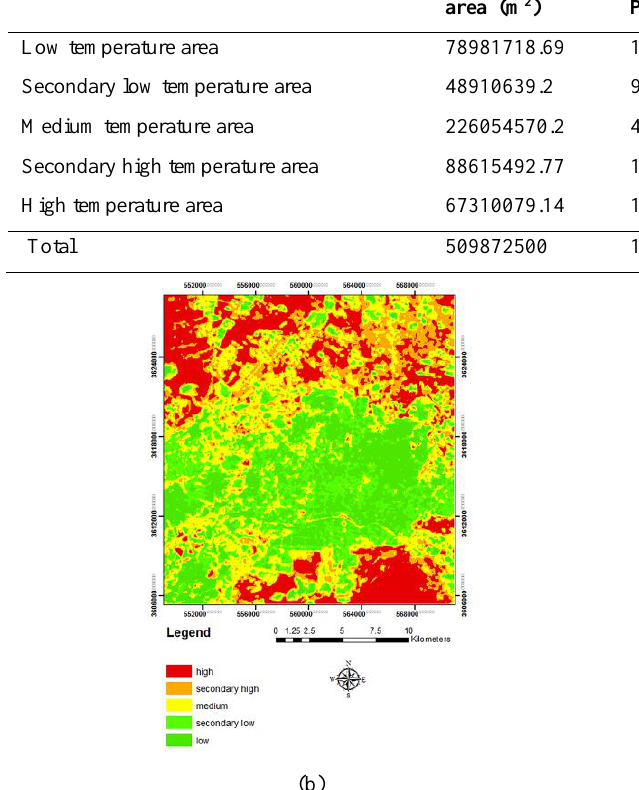
Figure 4. Classified land surface temperature layers for (a) 1998 and (b) 2014 node years